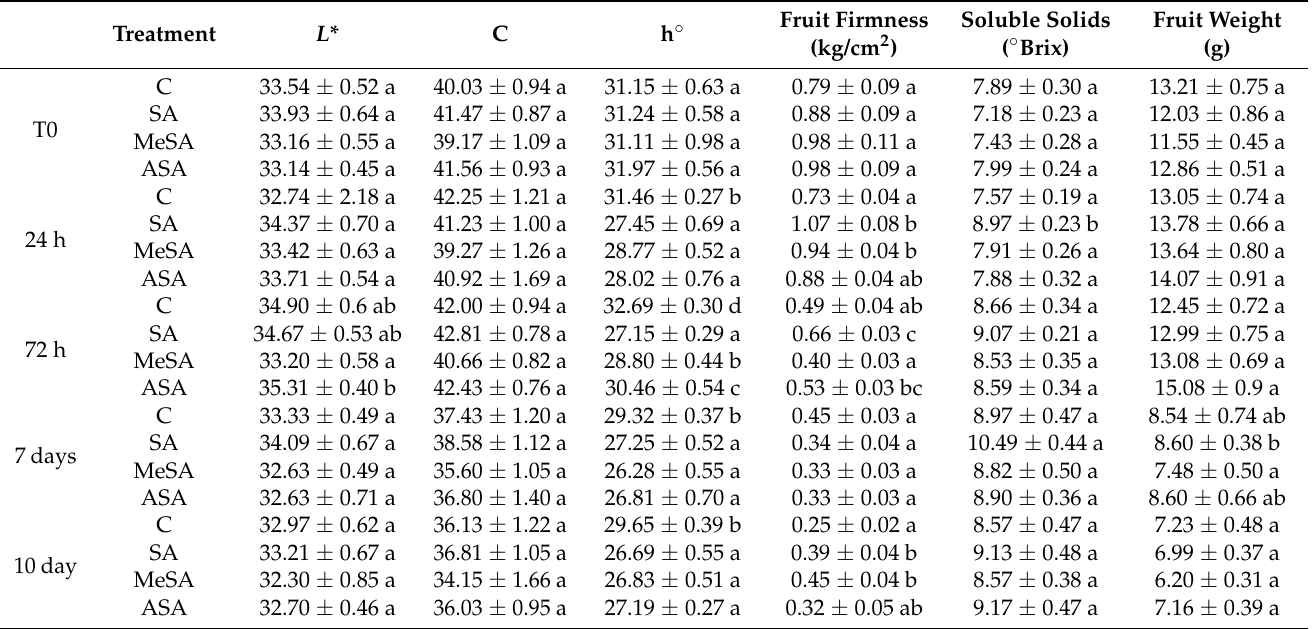
Table 1. Effects of different salicylates (SA, MeSA, ASA) on colour (lightness- L *, chroma- C and hue angle-h ◦ parameters), fruit weight (g), fruit firmness (kg/cm 2 ) and soluble solids content ( ◦ Brix) of strawberry fruits at five different sampling dates (T0, 24 h, 72 h, 7 days and 10 days after treatments with